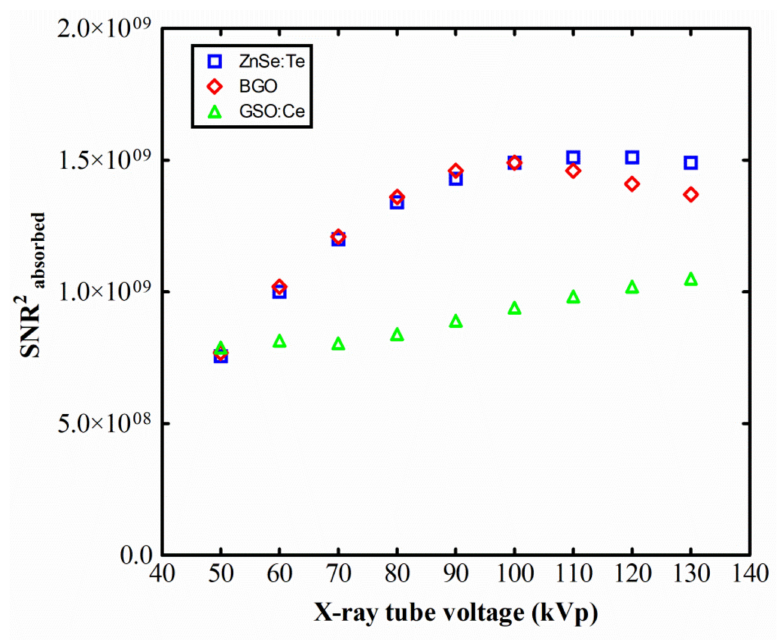
Figure 5. Signal-to-noise ratio squared absorbed of ZnSe: Te, BGO and GSO: Ce. The DQE absorbed values as a function of set tube voltage for the three crystals are shown in Figure 6, which also demonstrates that for all scintillators the DQE absorbed values are equal to EAE (see Figure 1). Again, ZnSe:Te demonstrates the highest DQE absorbed values at high tube voltages (more than 110 kVp).